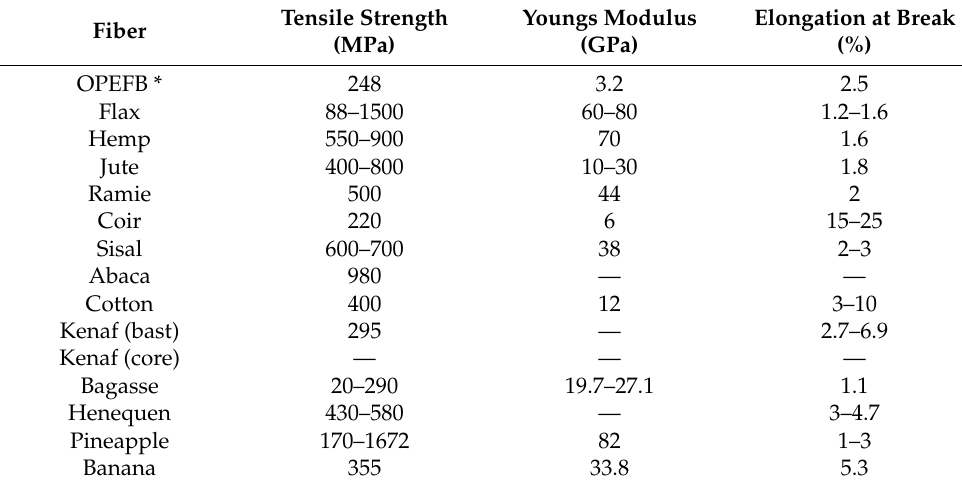
Table 4. Mechanical properties of natural fibers